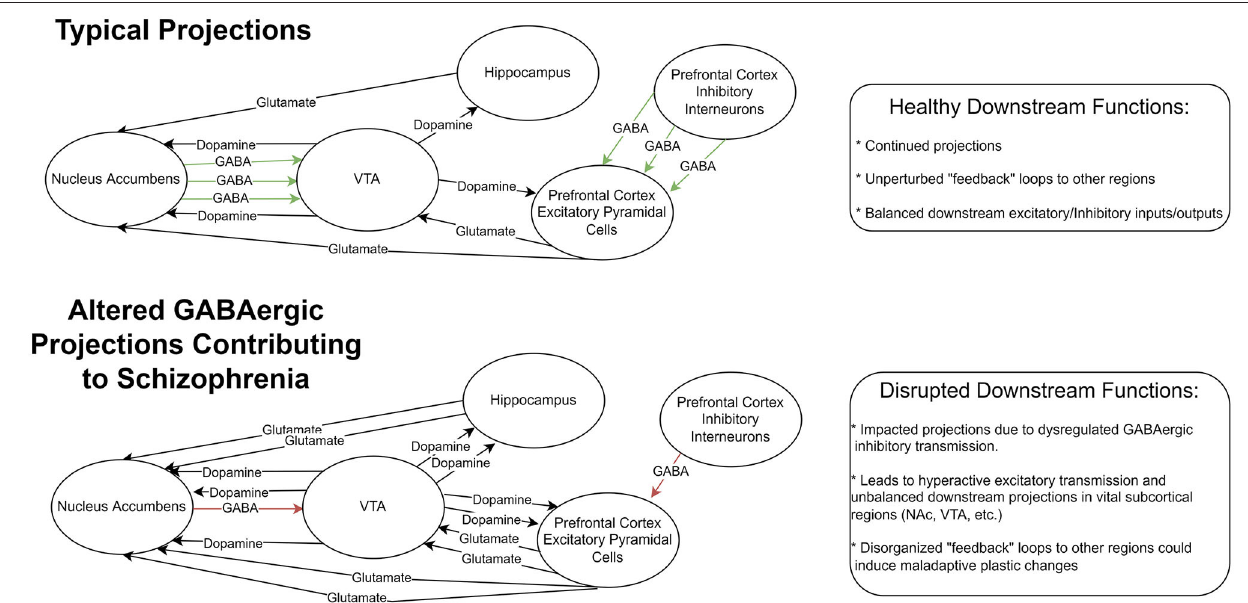
FIGURE 1 | Representation of GABAergic circuitry in prefrontal cortex. Top row: A sample diagram depicting typical projections in a healthy system with functioning feedback loops and balanced excitatory and inhibitory inputs and outputs. Botom row: a sample diagram of this system altered by GABAegic cell changes seen in Schizophrenia. This altered system includes reduced inhibitory GABAergic signaling resulting in downstream hyperactive excitatory transmission. These could result in disrupted feedback systems and maladaptive plastic changes in vital subcortical